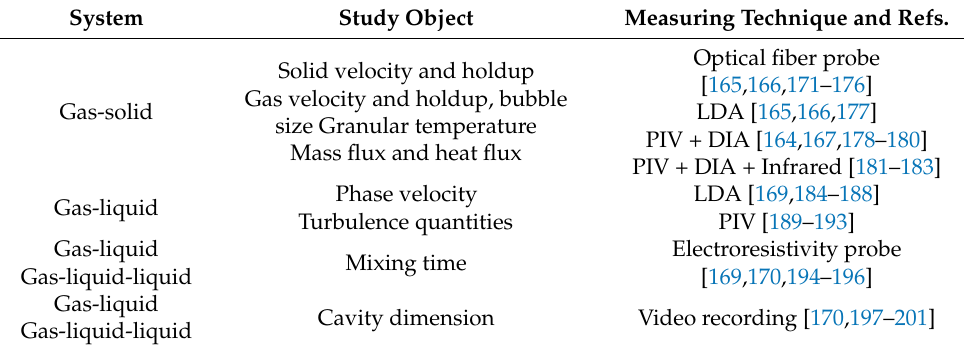
Table 1. Experimental validation